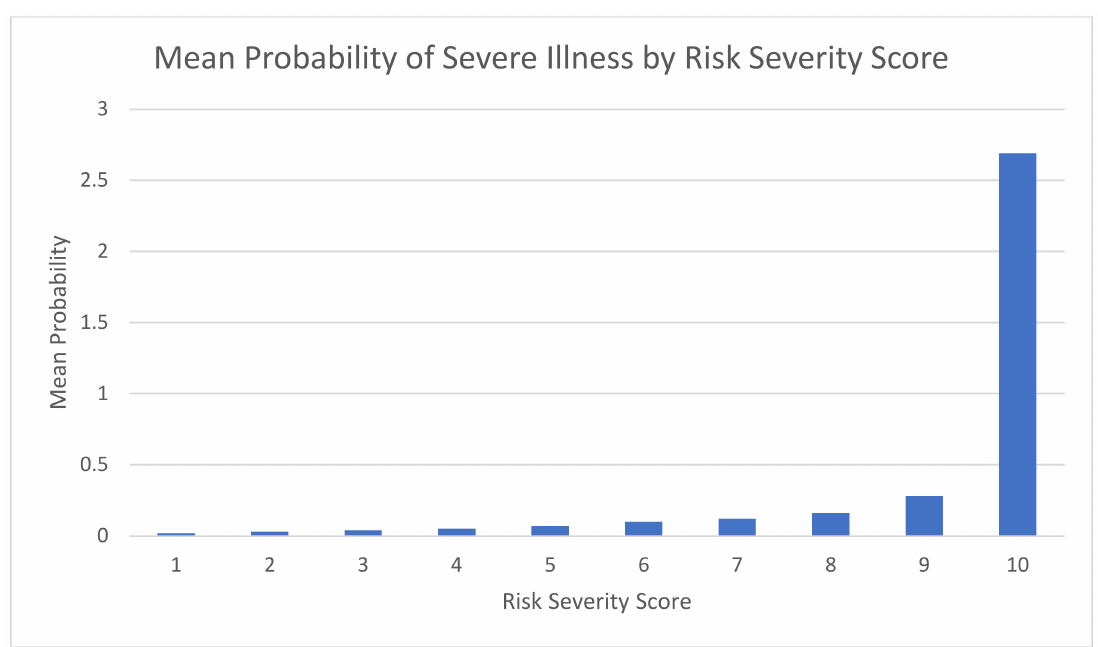
Figure 1. Mean probability by risk severity score, model development population (‘train’ group) Jan 2022 (N = 130,000), Maccabi HealthCare Services,